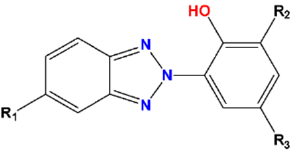
Figure 1. Benzotriazole UV stabilizer.